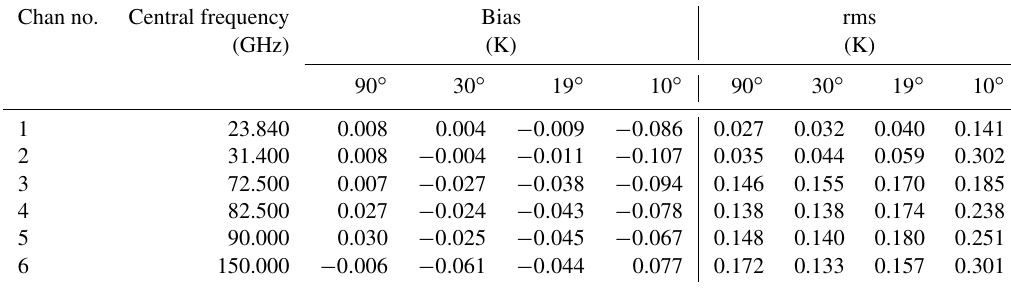
Table 4. Same as Table 3 but for the LWP_K2W instrument. Chan